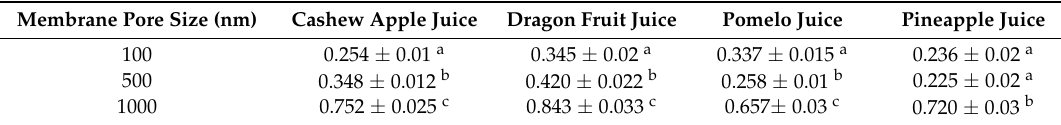
Different letter superscripts show significant differences among the men values in the same column.